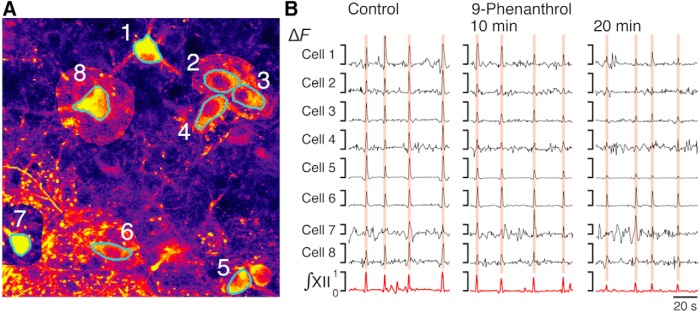
Single-neuron GCaMP6f fluorescence signal tracking during TRPM4 channel inhibition. A, Single optical plane image of the pre-BötC region with cells of interest (1–8) in a rhythmically active neonatal medullary in vitro slice preparation from the VgluT2-GCaMP6f transgenic mouse. Regions of interest detected algorithmically (see Methods) for quantifying somal fluorescence transients are outlined in cyan. Color scale of pixels immediately surrounding some of the cells (2, 3, 7, 8) was adjusted to more clearly delineate neuron soma in this image. B, Examples of time series of single-neuron GCaMPF6f fluorescence transients synchronous with integrated inspiratory hypoglossal activity (∫ XII, red) used for single-neuron ΔF analysis during control period, and 10 and 20 min after bath application of 50 µm 9-phenanthrol.